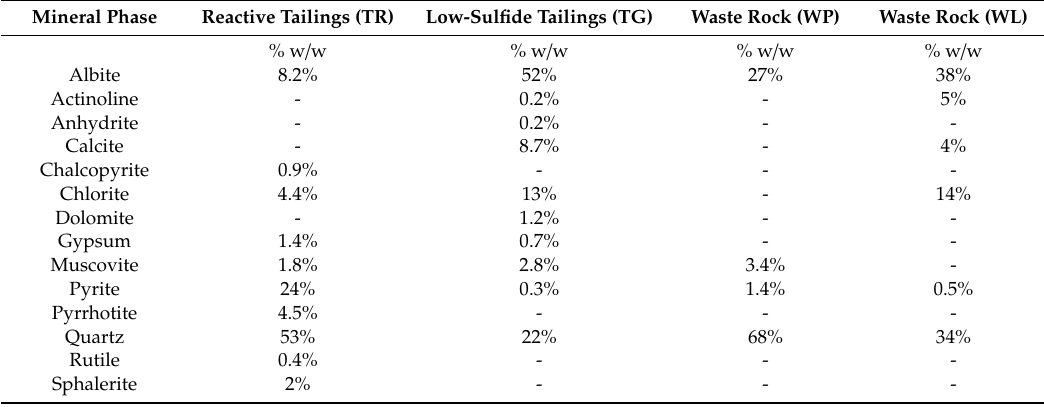
Table 2. Mineralogical and geochemical composition of reactive tailings and cover materials. Mineral Phase